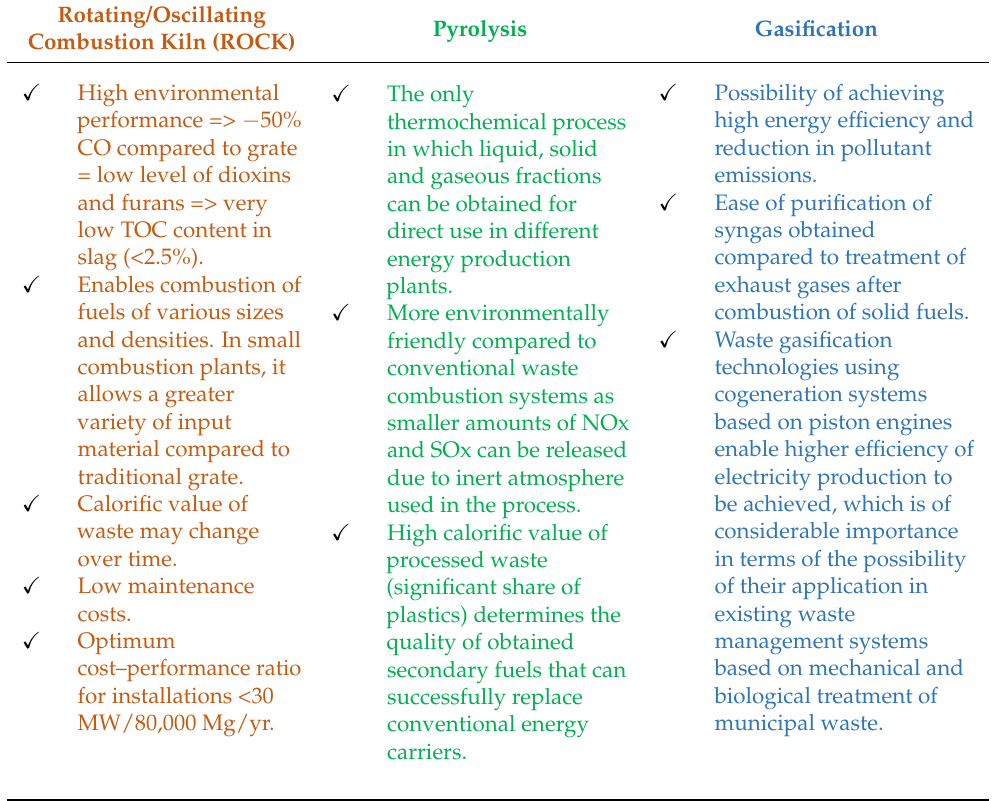
Figure 5. Thermal conversion technologies for municipal waste [2]. Table 3. Factors determining use of thermal conversion methods of municipal waste [13,37–39].